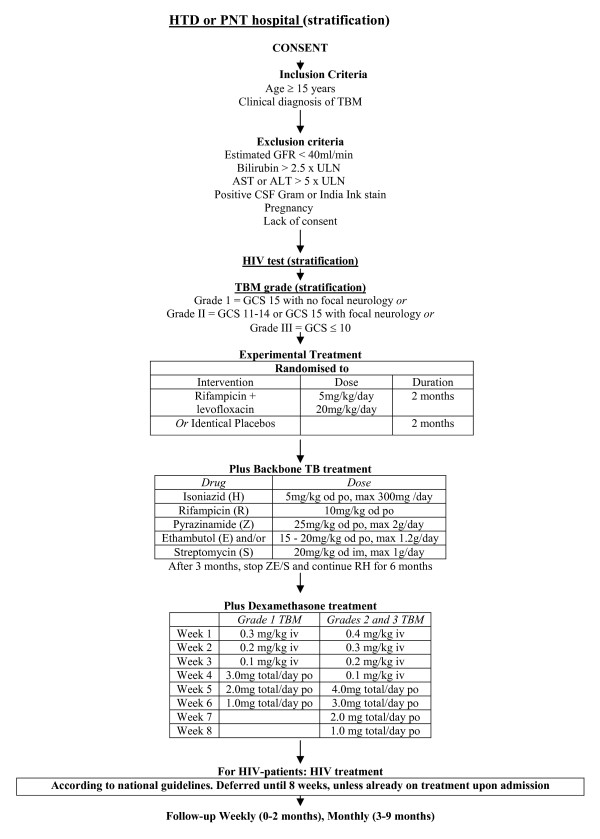
Trial flow diagram.